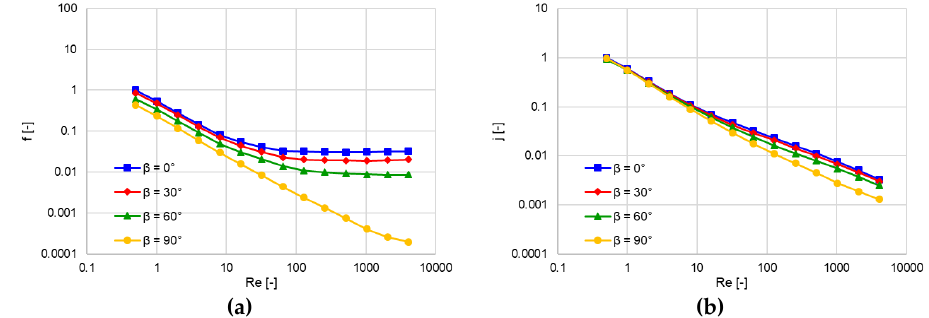
Figure 10. REV characterization for the offset-strip fins: ( a ) Calculation of the Fanning friction factor as a function on Reynolds ( Re ) number and flow angle; ( b ) calculation of the Colburn factor as a function on Re number and flow angle. Results are normalized with respect to a reference value (the maximum value of the offset-strip fins dataset).